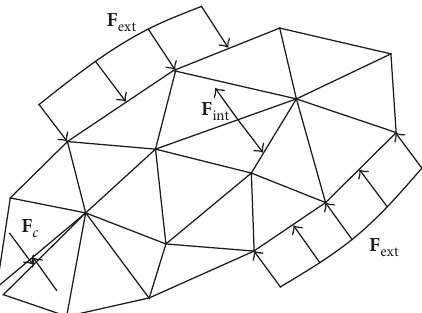
Figure 2: The schematic diagram of the internal resisting forces, the external loads, and the contact forces (the contact force happens when two blocks contacted).